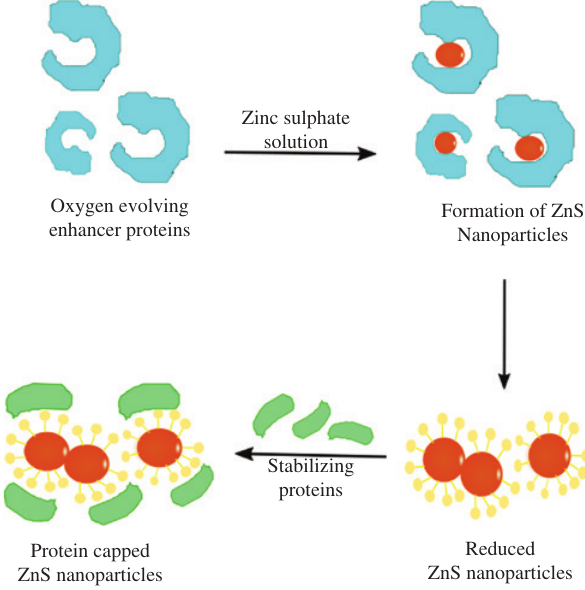
Figure 12: Mechanism describing the synthesis and stabilization of zinc sulfide nanoparticles by algal